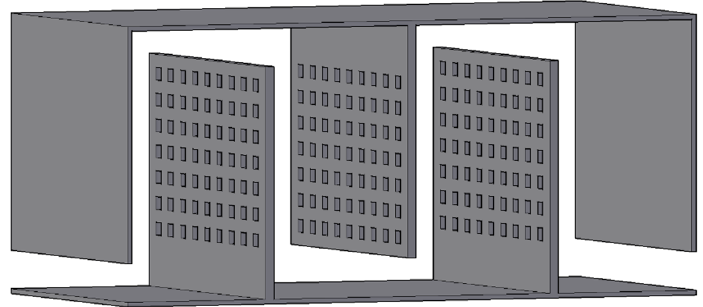
Figure 1. Three-dimensional schematic view of the computational domain.